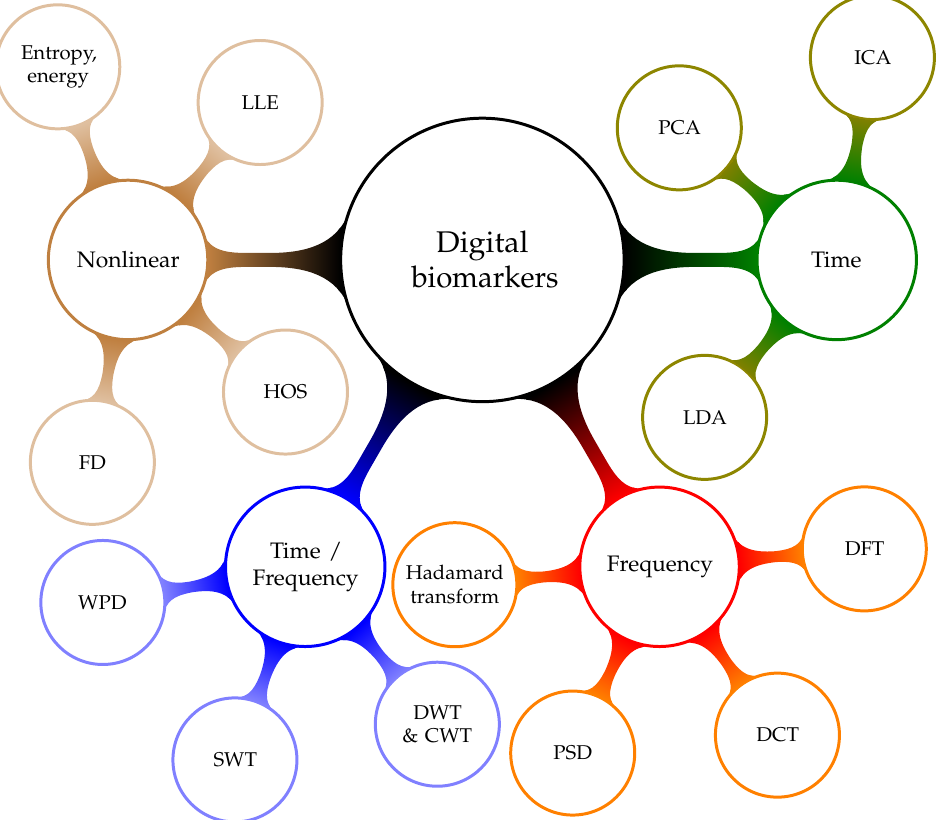
Figure 4. Taxonomy of digital